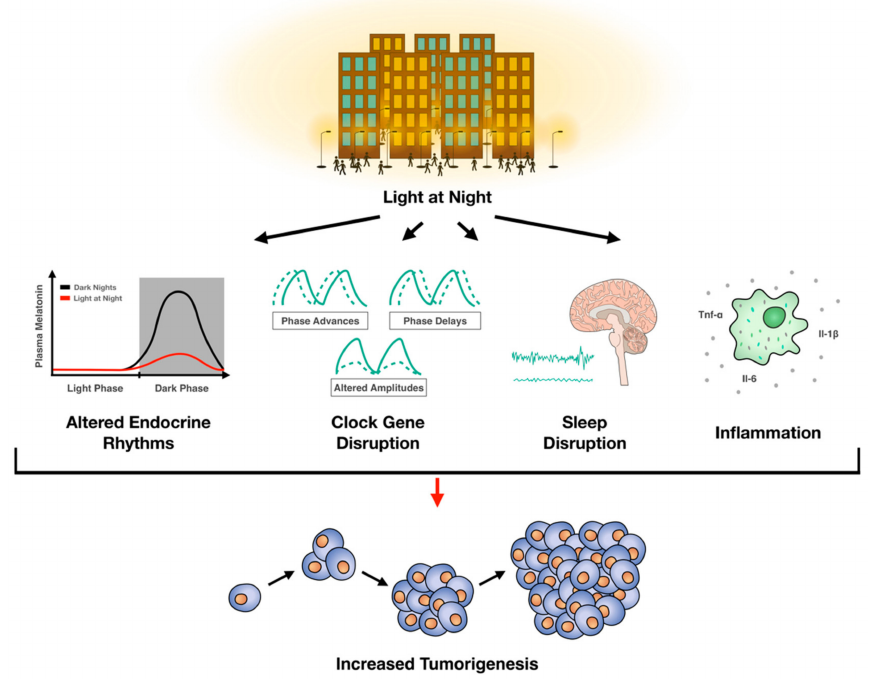
Figure 1. Summary of the e ff ects of artificial light at night on